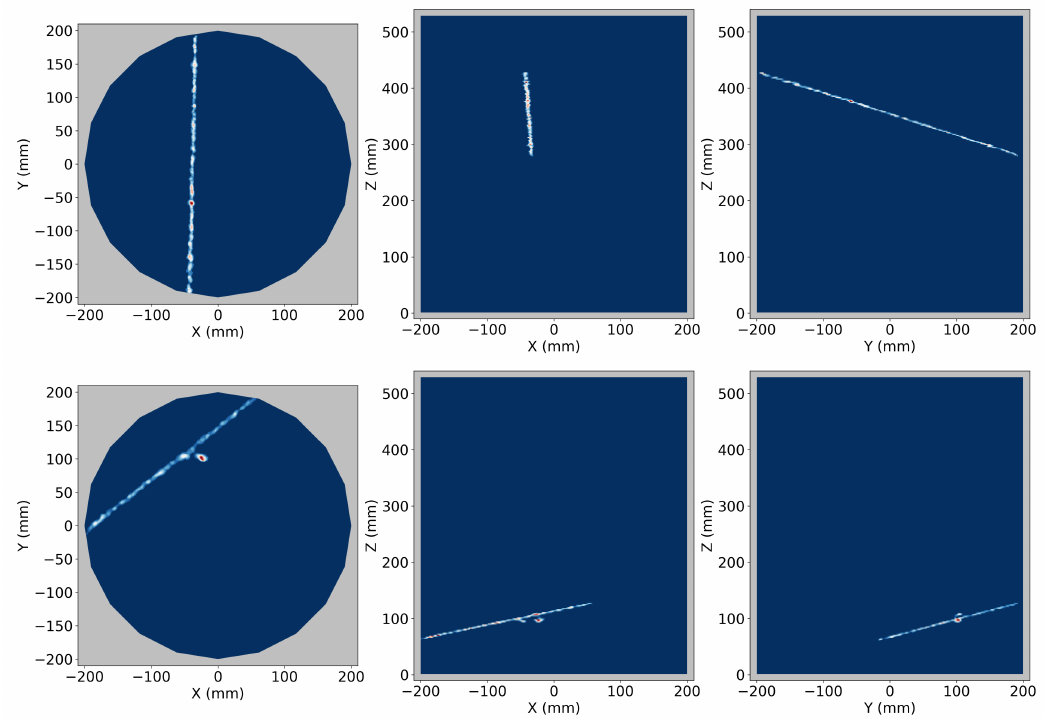
Figure 7 . Two muon events in NEXT-White data after RL deconvolution, shown in three Cartesian projections. The top event is of a “clean” muon, while the bottom one also contains a delta